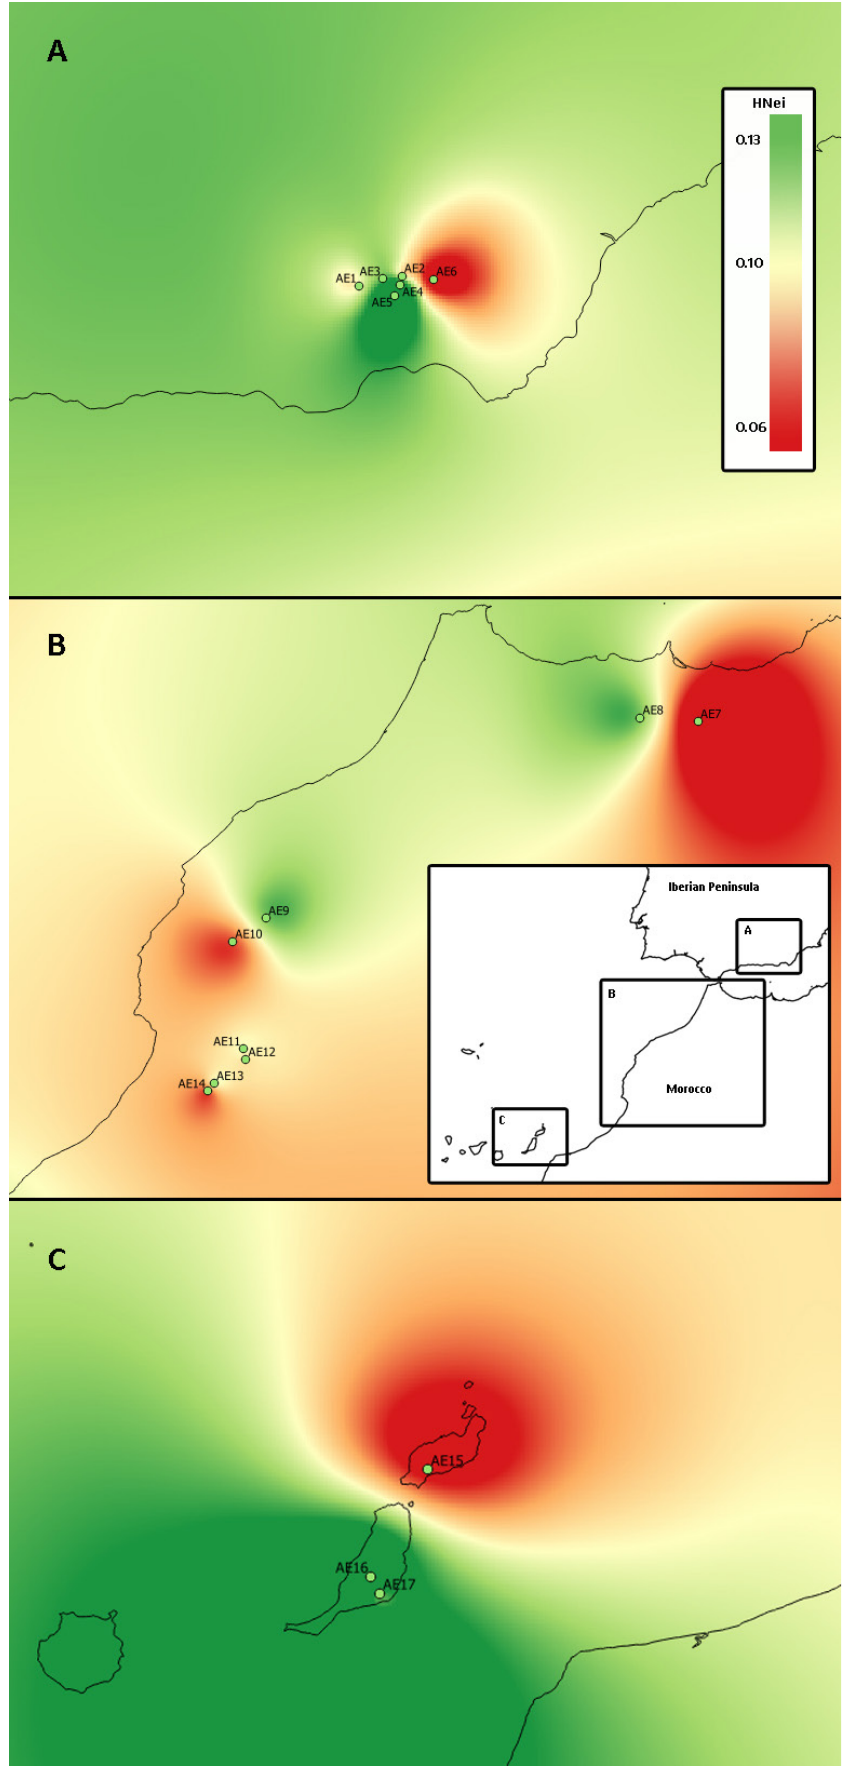
Figure 2. Nei’s gene diversity pattern (red = low; yellow = medium; green = high) obtained with QGIS (QGIS- Development-Team, 2017); A, Iberian Peninsula; B, Morocco; C, Canary